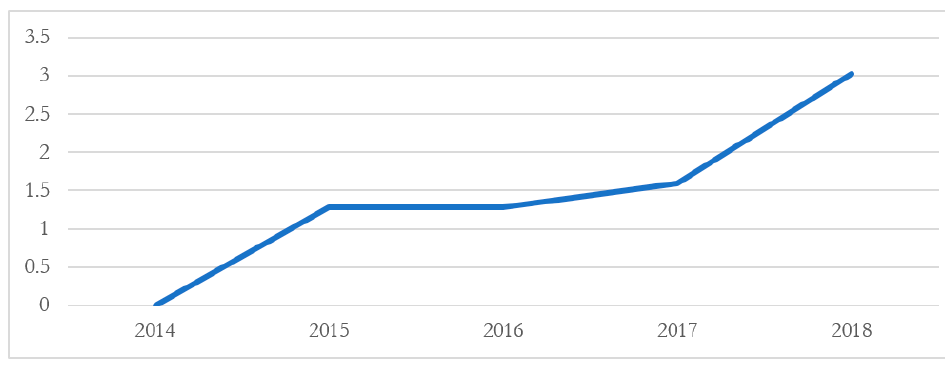
Figure 4. Change in GDP (in% compared to the BAU scenario). Source: Authors, based on simulations.